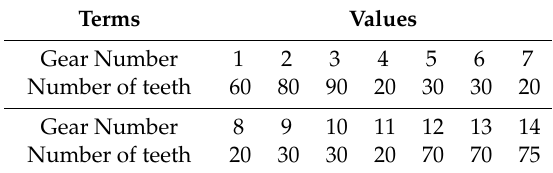
Figure 8. Steps form for the wind speed simulation. Table 1. Gear number.